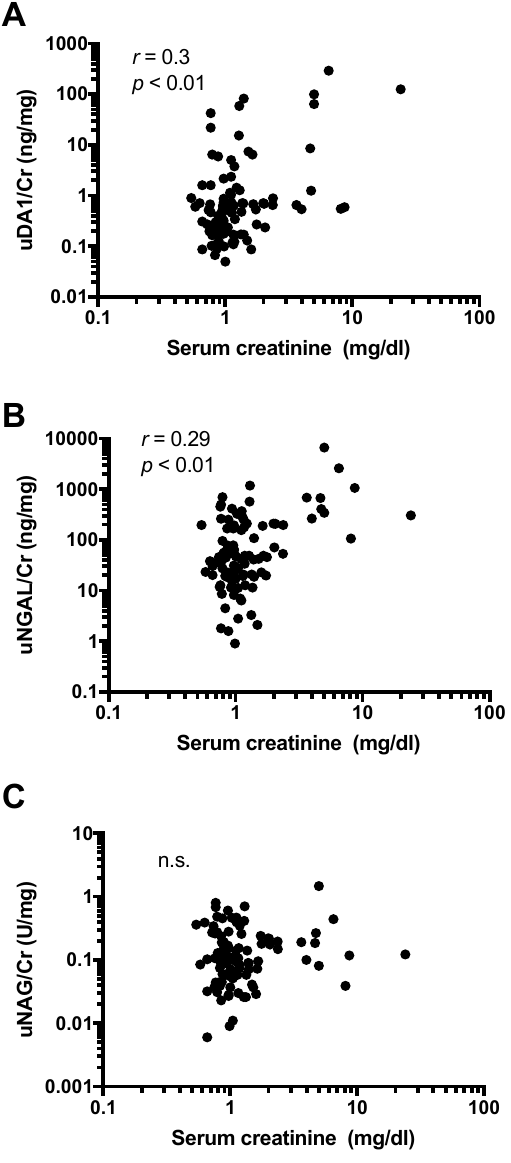
Figure 2. Correlation between serum Cr and urinary levels of DA1/Cr ( A ); NGAL/Cr ( B ); and NAG/Cr ( C ) in leptospirosis patients. n.s. not significant.